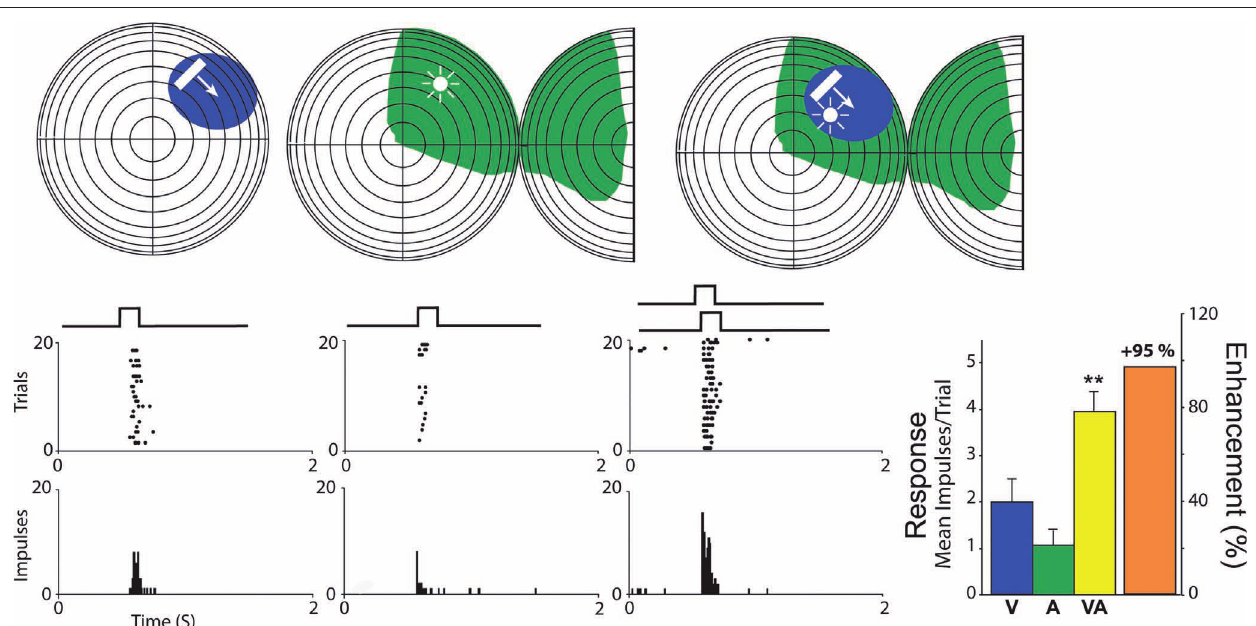
burst delivered from a speaker placed within the auditory receptive fi eld (speaker location is depicted by the icon). Cross-modal stimuli consisted of the visual and auditory stimuli presented together. Visual and auditory receptive fi elds are shaded in blue and green. Bottom: Neuronal responses for visual (blue), auditory (green), and cross-modal (yellow) conditions are demonstrated with rasters and peristimulus time histograms. To the right: Bar graphs summarizing the mean response to all three conditions with the proportional enhancement observed in the cross-modal condition represented in